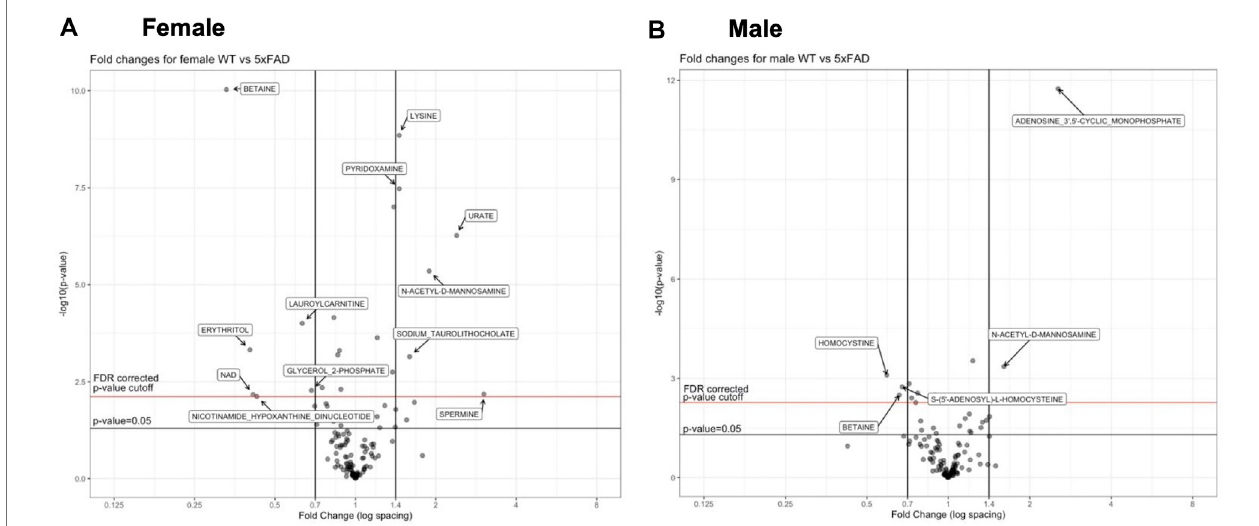
FIGURE 3 | Volcano plots of metabolities that changed signi fi cantly in 5xFAD mice as compared to wild-type (WT) mice.